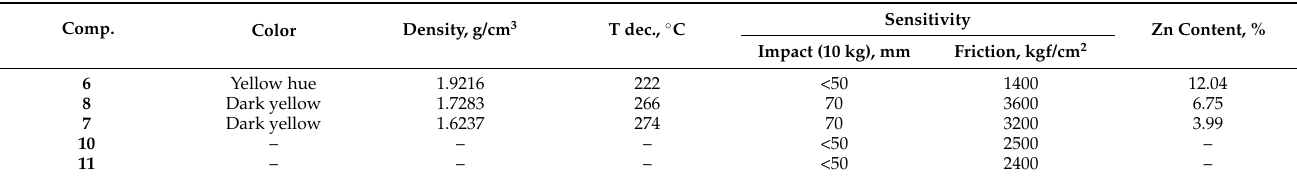
Table 3. Physicochemical properties of compounds 6 , 7 , and 8